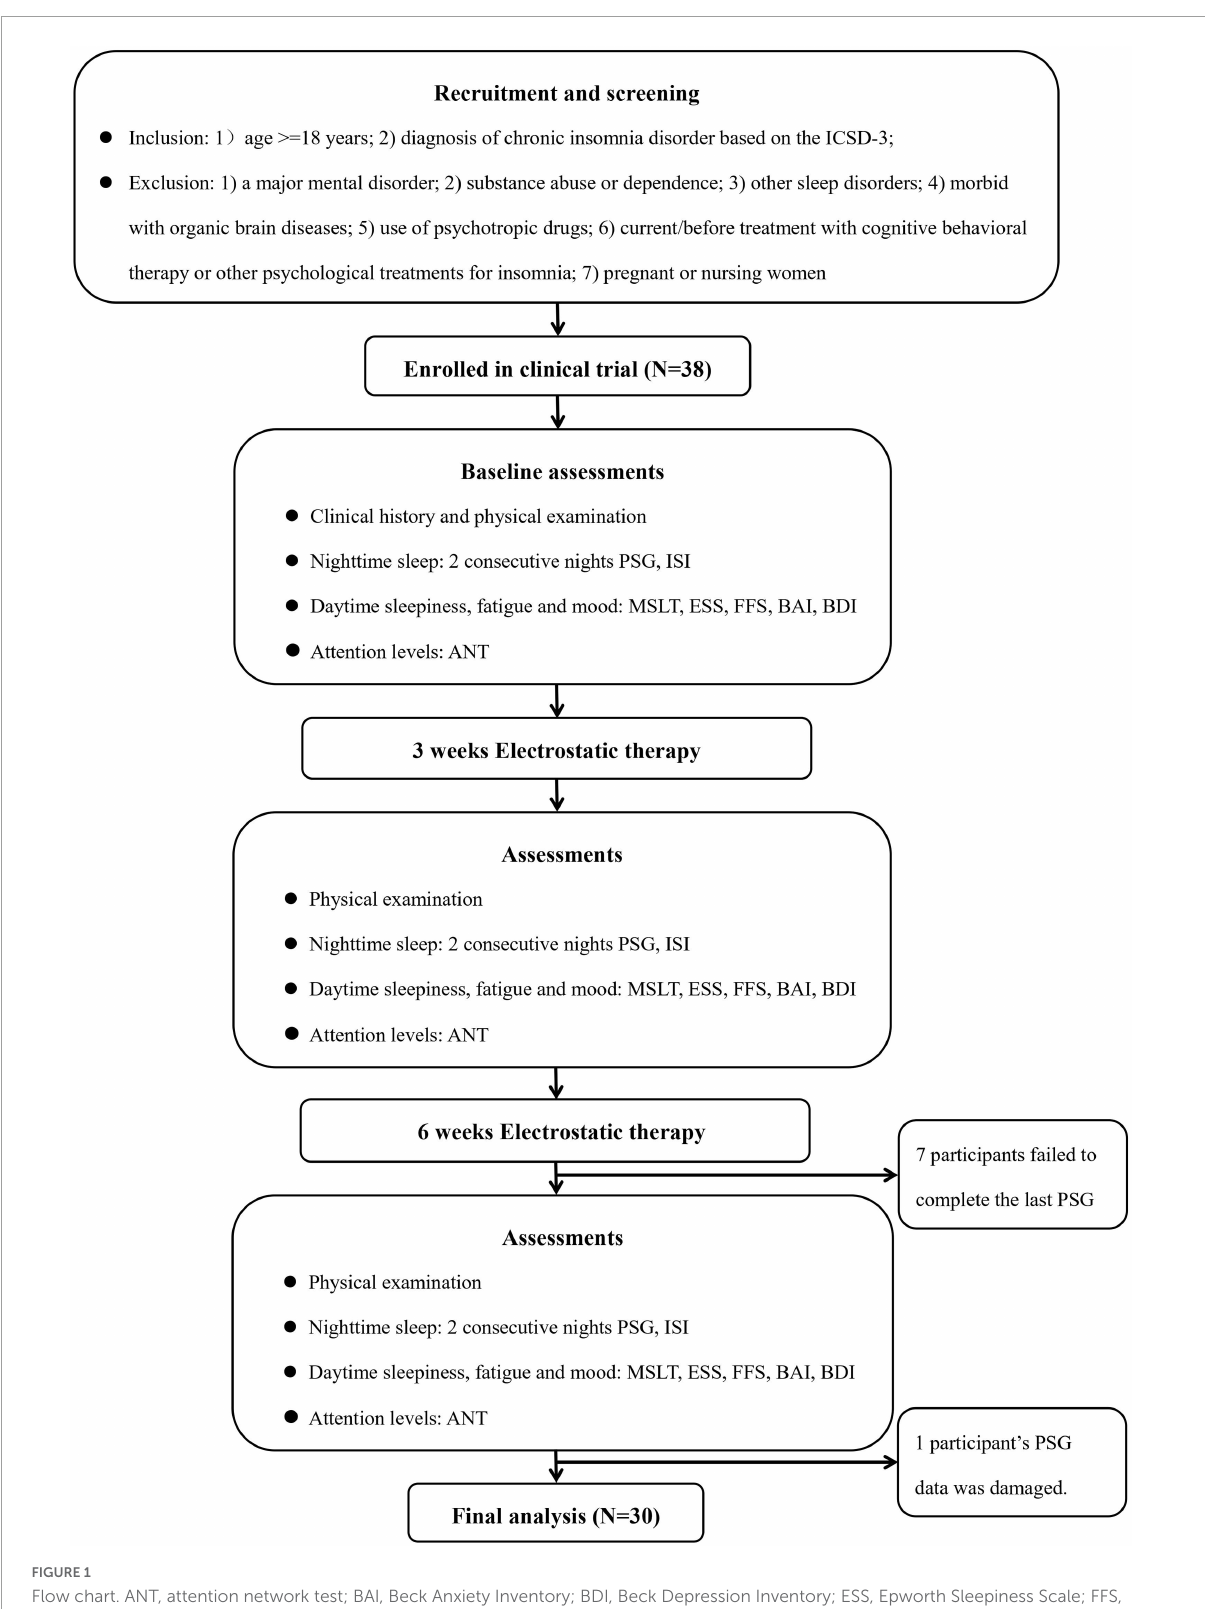
FIGURE1 Flow chart. ANT, attention network test; BAI, Beck Anxiety Inventory; BDI, Beck Depression Inventory; ESS, Epworth Sleepiness Scale; FFS, Flinders Fatigue Scale; ICSD-3, the International Classification of Sleep Disorder, third edition criteria; ISI, Insomnia Severity Index; MSLT, multiple sleep latency test; PSG, polysomnography; PSQI, Pittsburgh Sleep Quality